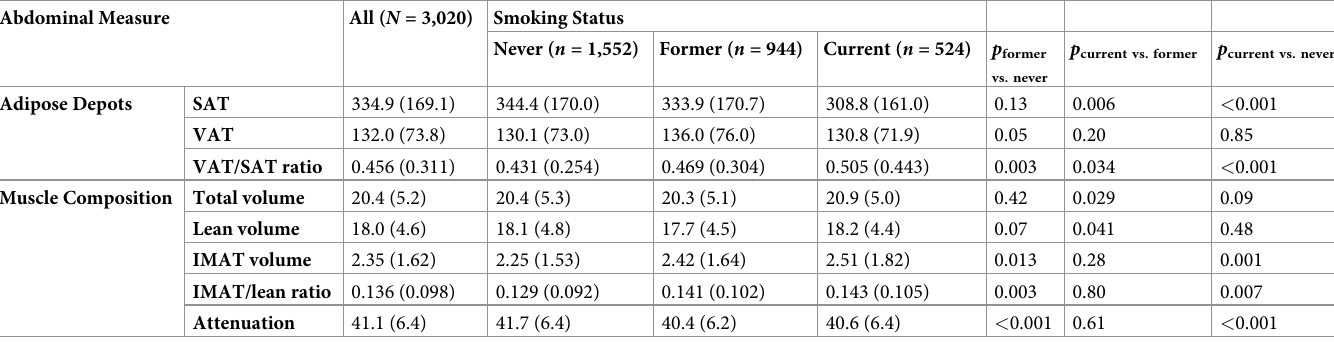
Table 2. Unadjusted Y25 CT measures of abdominal adipose tissues and muscle composition [mean (SD]) by Y25 smoking status � . Abdominal Measure All ( N = 3,020) Smoking Status